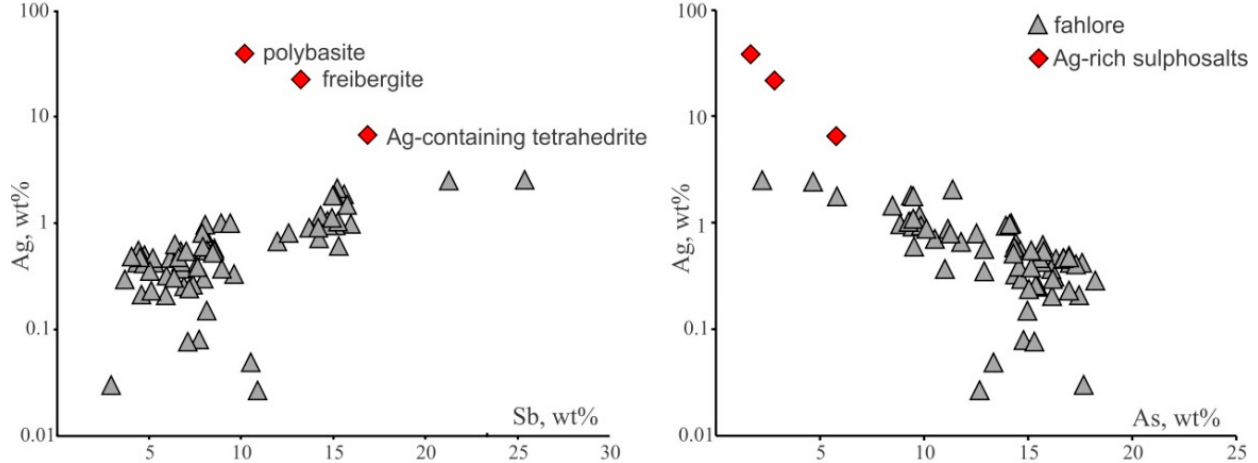
Figure 27. Dependence of the silver concentration on the arsenic and antimony contents in the fahlore and silver sulphosalts, the Novo-Uchaly lode.